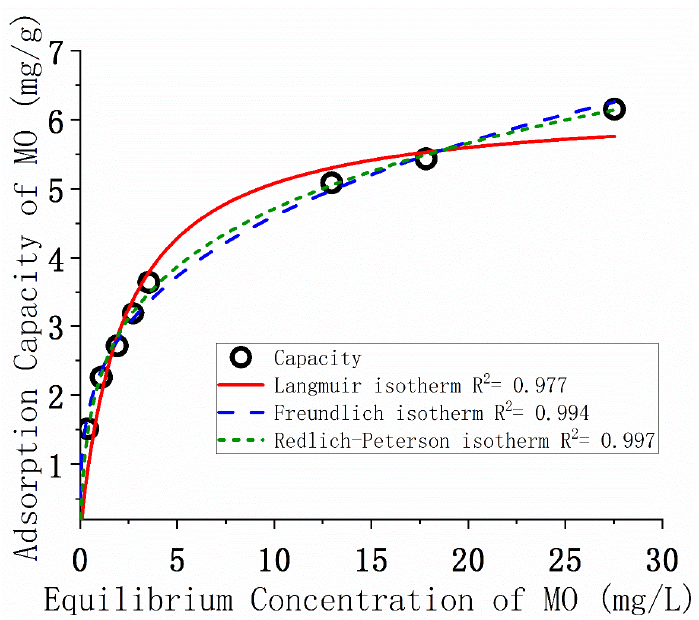
Figure 10. MO adsorption by P-MMt-C400 in different equilibrium concentrations, fitted by the Langmuir, Freundlich, and Redlich–Peterson isotherm models.